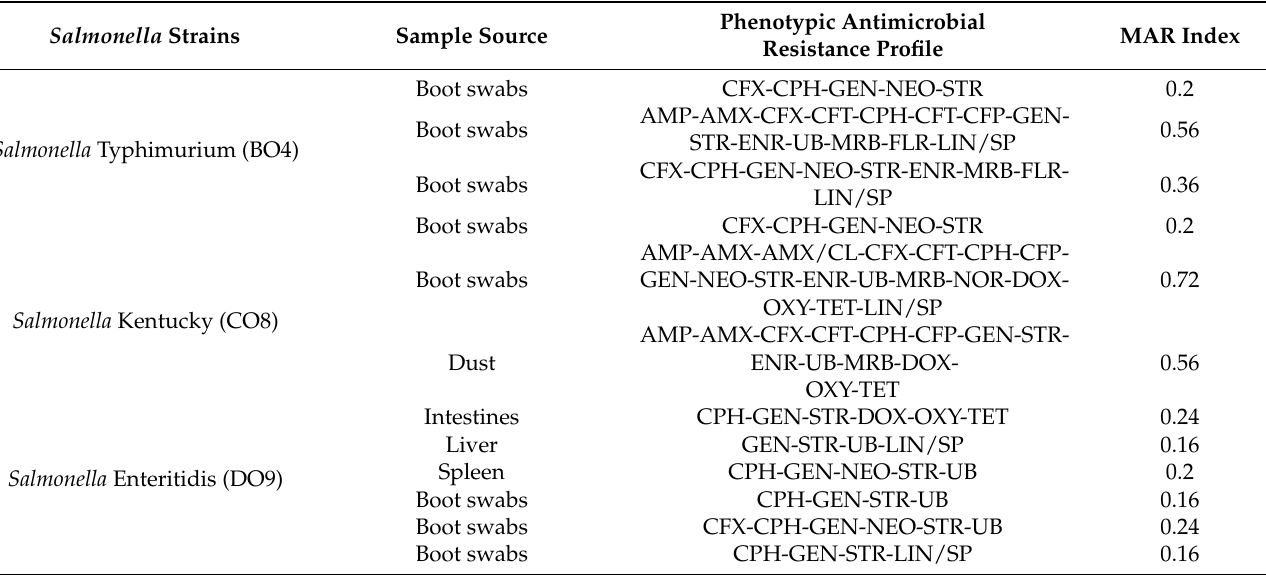
Table 4. Multiple antibiotic resistance index (MAR index) and phenotype pattern of Salmonella enterica spp. Enterica, all identified serovars isolates from samples of poultry.